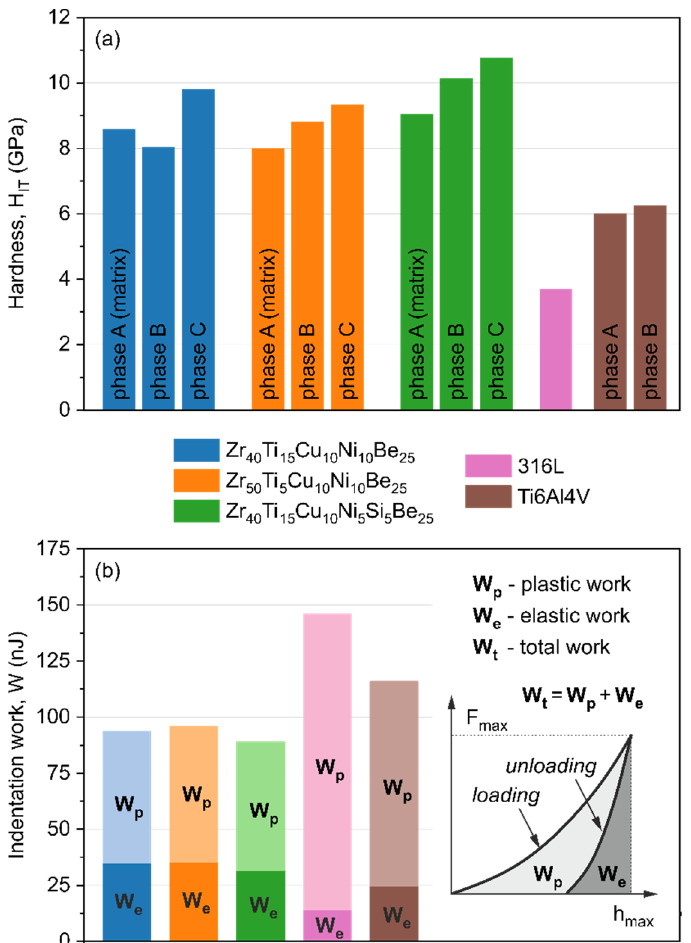
Figure 2. Bar plot representing the hardness of different phases observed in the materials ( a ) and the deformation energies ( b ) obtained in nanoindentation tests for the Zr 40 Ti 15 Cu 10 Ni 10 Be 25 , Zr 50 Ti 5 Cu 10 Ni 10 Be 25 , and Zr 40 Ti 15 Cu 10 Ni 5 Si 5 Be 25 alloys, as well as reference 316L stainless steel and Ti6Al4V alloy.